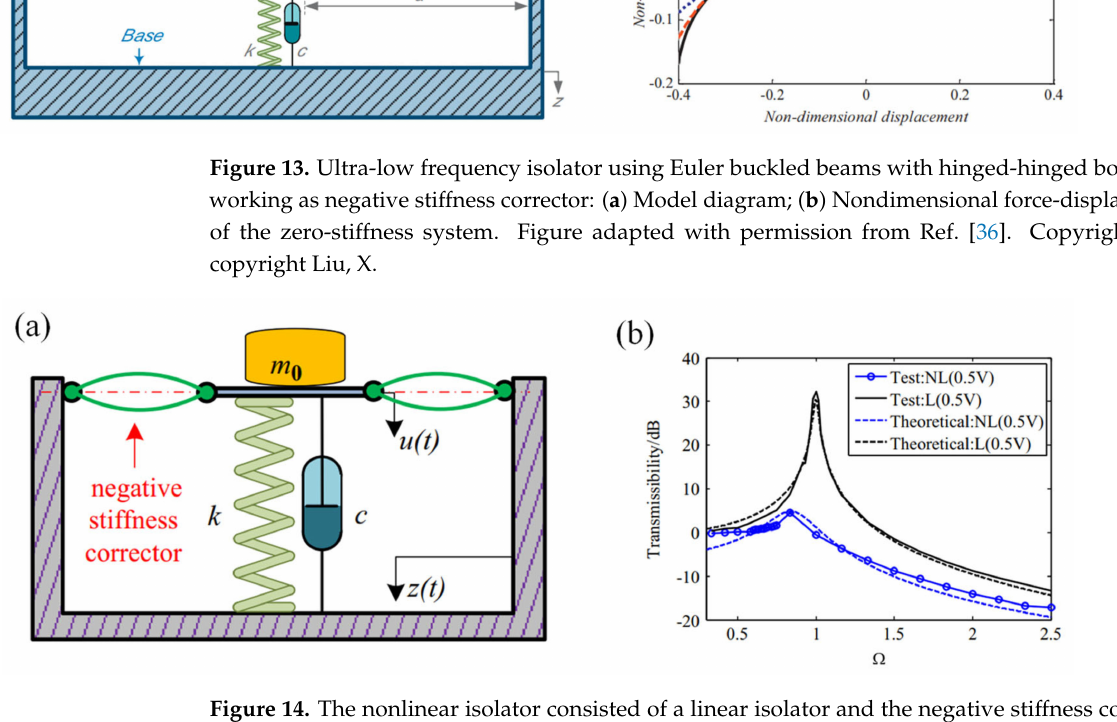
Figure 14. The nonlinear isolator consisted of a linear isolator and the negative stiffness corrector: ( a ) Model diagram; ( b ) The acceleration transmissibility of the linear and nonlinear isolator. Figure adapted with permission from Ref. [38]. Copyright 2014, copyright Huang,